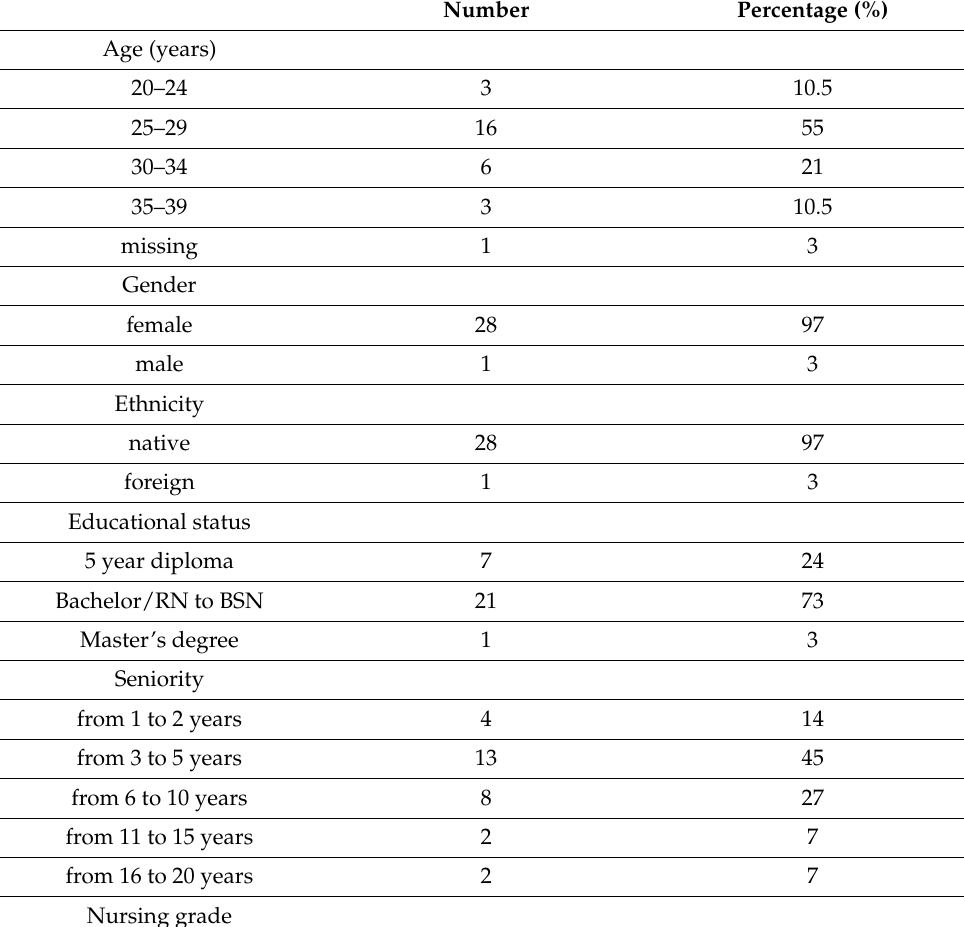
Table 3. Demographic data for nurse participants ( n =